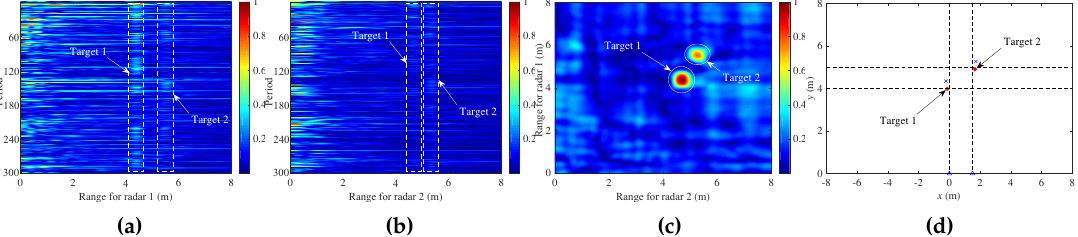
Figure 21. Results of Experiment 4.2: ( a ) range profile plane for Radar 1; ( b ) range profile plane for Radar 2; ( c ) cross-correlation image; and ( d ) localization result.